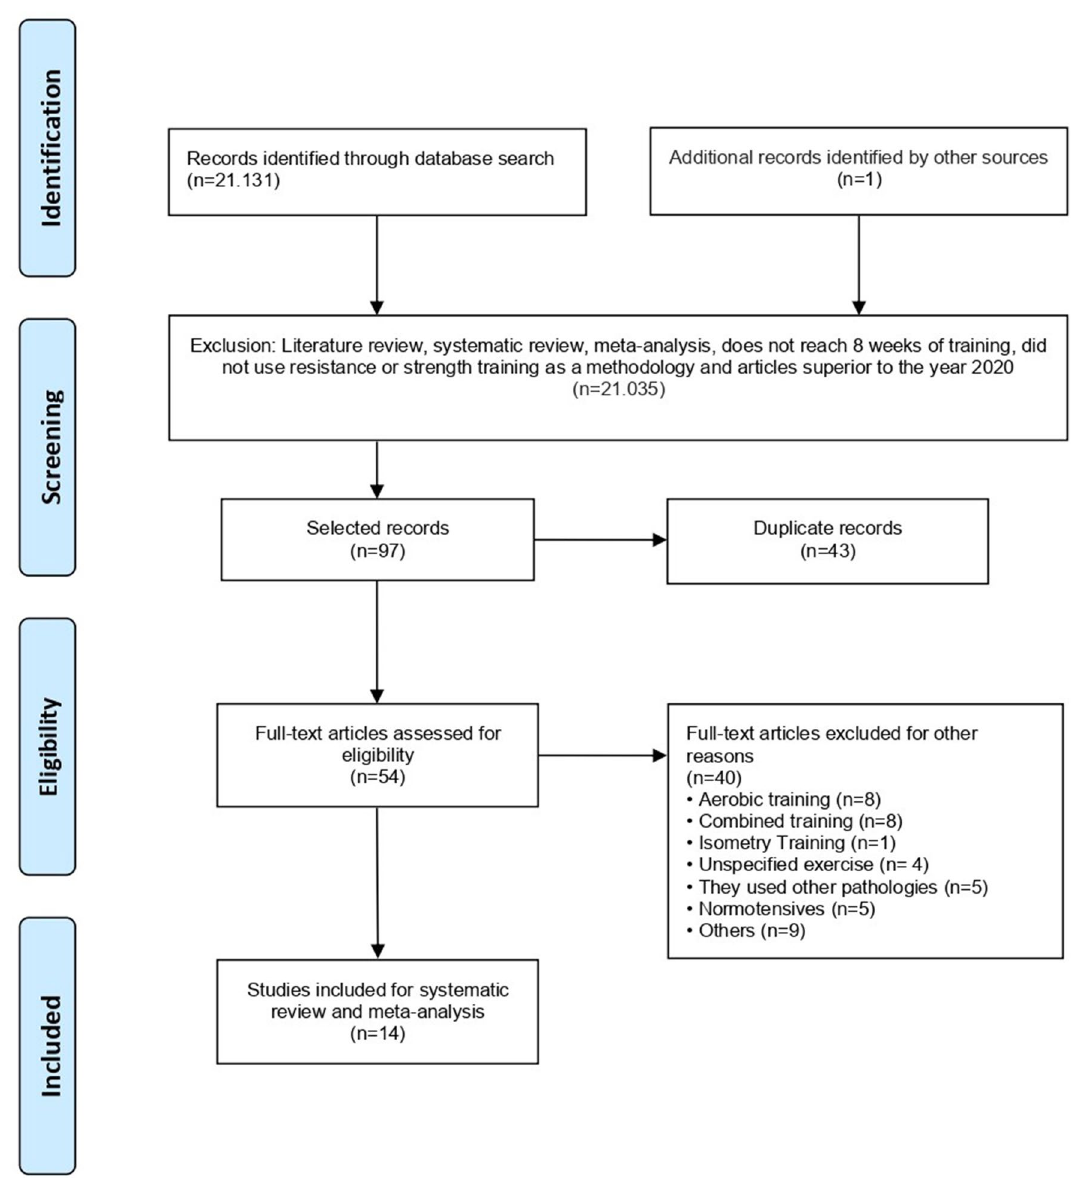
Figure 1. Flowchart corresponding to the identification, screening, eligibility, and included criteria of this Load intensity. Most of the included studies used a load intensity of 60% 25,26,33 or 70% 20,29 of the 1RM. Other studies used the Borg scale with intensity scoring of 11–15 27 and 11–13 points 24 , besides also using 40–60% of the heart rate 22 , 50% 28 of the 1RM, the 10RM test 6 , and the 10-15RM test 32 . One study did not indicate the inten- sity and was excluded 23 . These parameters indicated the predominant moderate load intensity of the strength training protocols (Fig. 4A indicates data on SBP, and Fig. 4B indicates data on DBP). This meta-analysis shows that the most commonly used load intensity in strength training for the treatment of arterial hypertension is 60–70% of 1RM, and that studies which used a load intensity of more than 60% are considered more homogene- ous (I 2 = 0%—both SBP and DBP). In addition, we can see a robust reduction in AH values accompanied by a statistically significant change in SBP (mean difference = − 12.22; 95% CI − 16.60 to − 7.84; p-value < 0.00001, Fig. 4A) and DBP (mean difference = − 2.10; 95% CI − 5.05 to 0.85; p-value = 0.16, Fig. 4B). A load intensity of less than 60%, even with high heterogeneity, led to a significant reduction in systolic blood pressure (mean dif- ference = − 2.97; 95% CI − 5.85 to − 0.08; I 2 = 54%; p-value = 0.04, Fig. 4A), but not in diastolic blood pressure (mean difference = − 3.59; 95% CI − 10.25 to 3.07; I 2 = 97%; p-value = 0.29, Fig. 4B). A moderate load intensity showed high heterogeneity, but a significant reduction in blood pressure values in hypertensive individuals for both systolic (mean difference = − 10.82; 95% CI − 14.12 to − 7.52; I 2 = 76%; p-value < 0.00001, Fig. 4A) and dias- tolic pressure (mean difference = − 6.96; 95% CI − 9.93 to − 3.99; I 2 = 86%; p-value < 0.00001, Fig. 4B). All studies